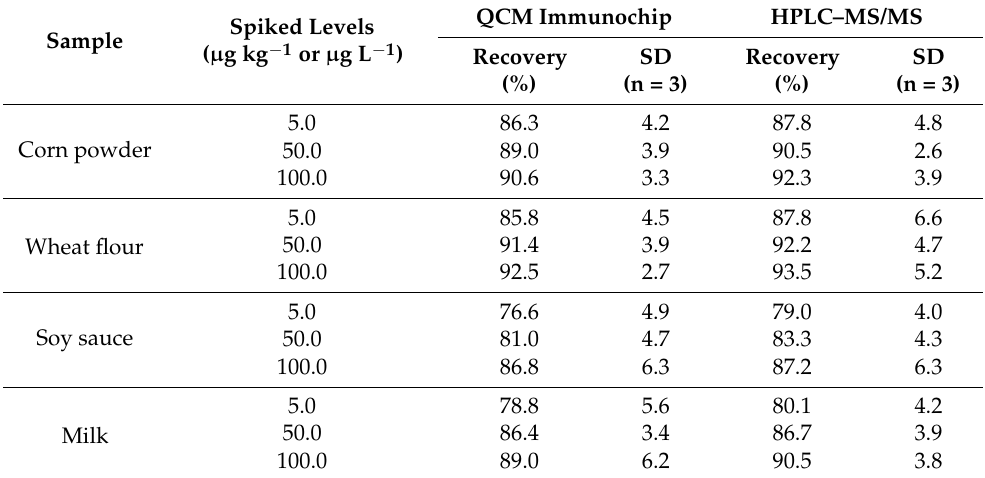
Table 1. Recovery results of ZEN from spiked samples determined by the proposed QCM im- munochip and